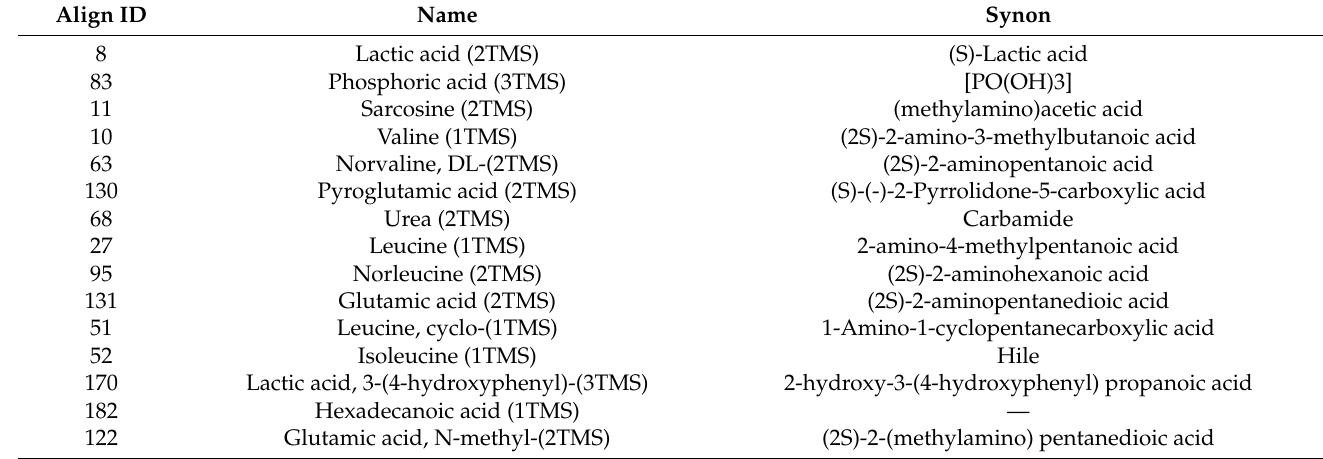
Table 1. The top 15 metabolites in serum by gas chromatography mass spectrometry